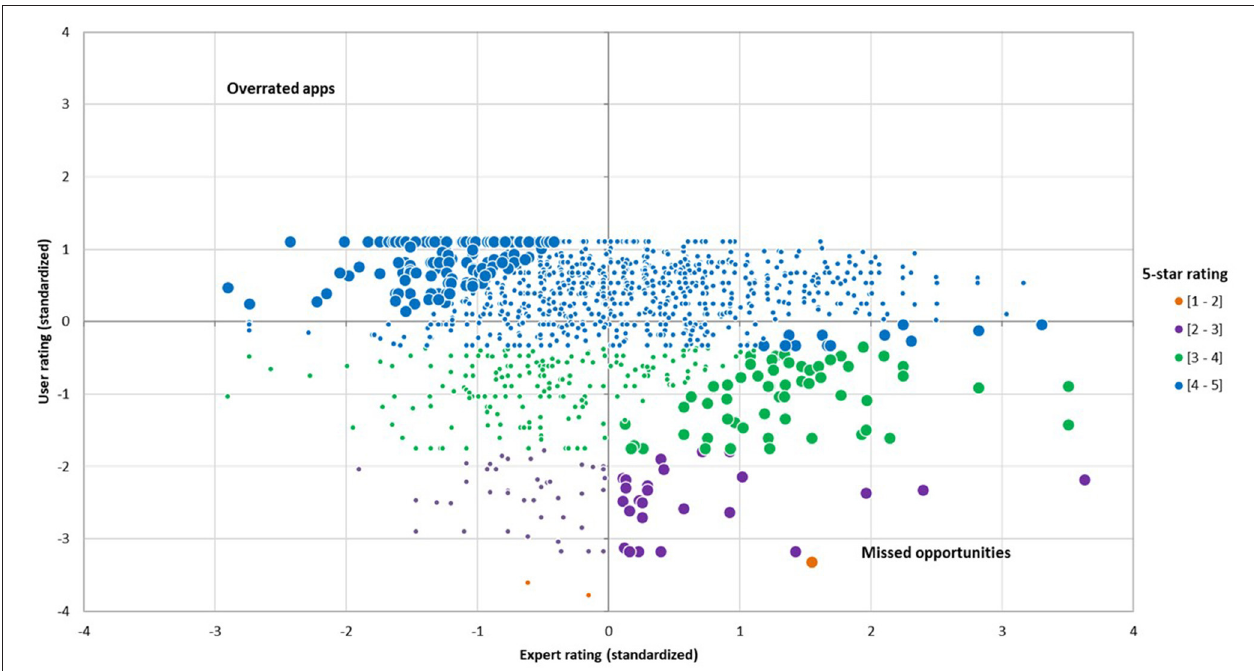
FIGURE 1 | Distribution of standardized user and expert ratings. This figure shows user-expert gaps for each level of 5-star ratings and identifies missed opportunities and overrated